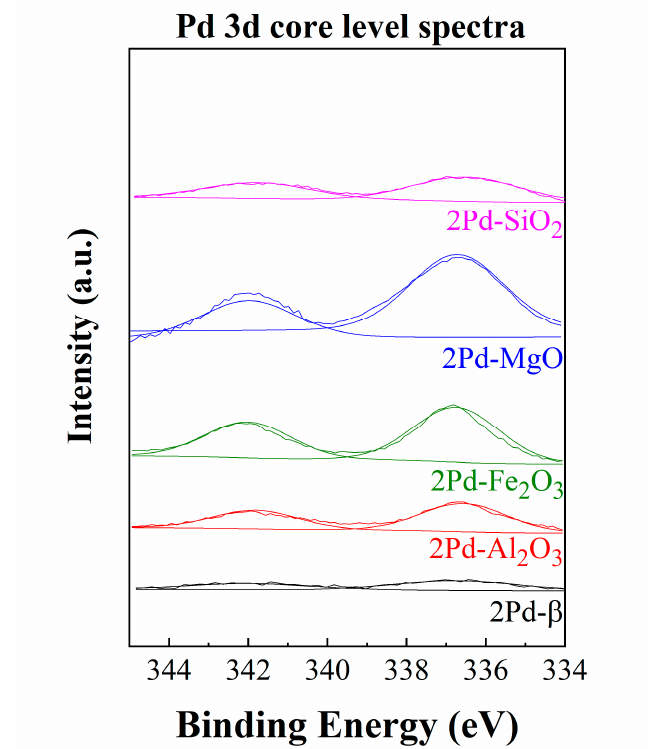
Figure 6. Pd 3d core level spectra of Pd-based catalysts (Pd content: 2 wt.%).